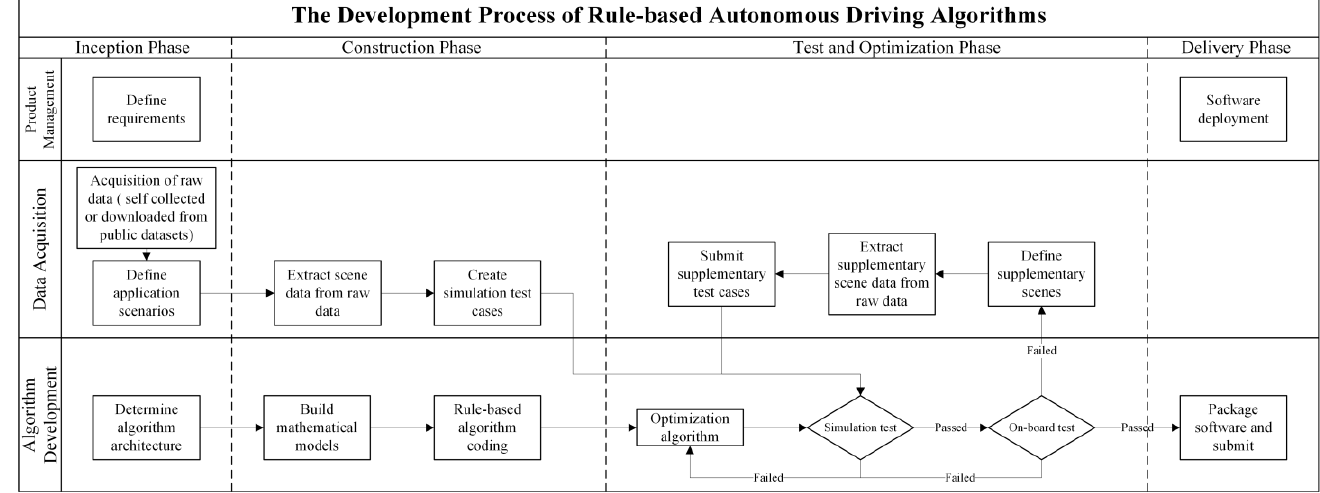
Figure 2. Rule-based algorithm development.